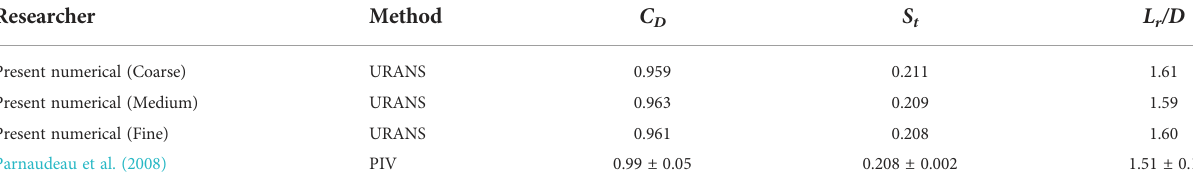
TABLE 2 Grid independence study of fl ow past a circular cylinder at Re =